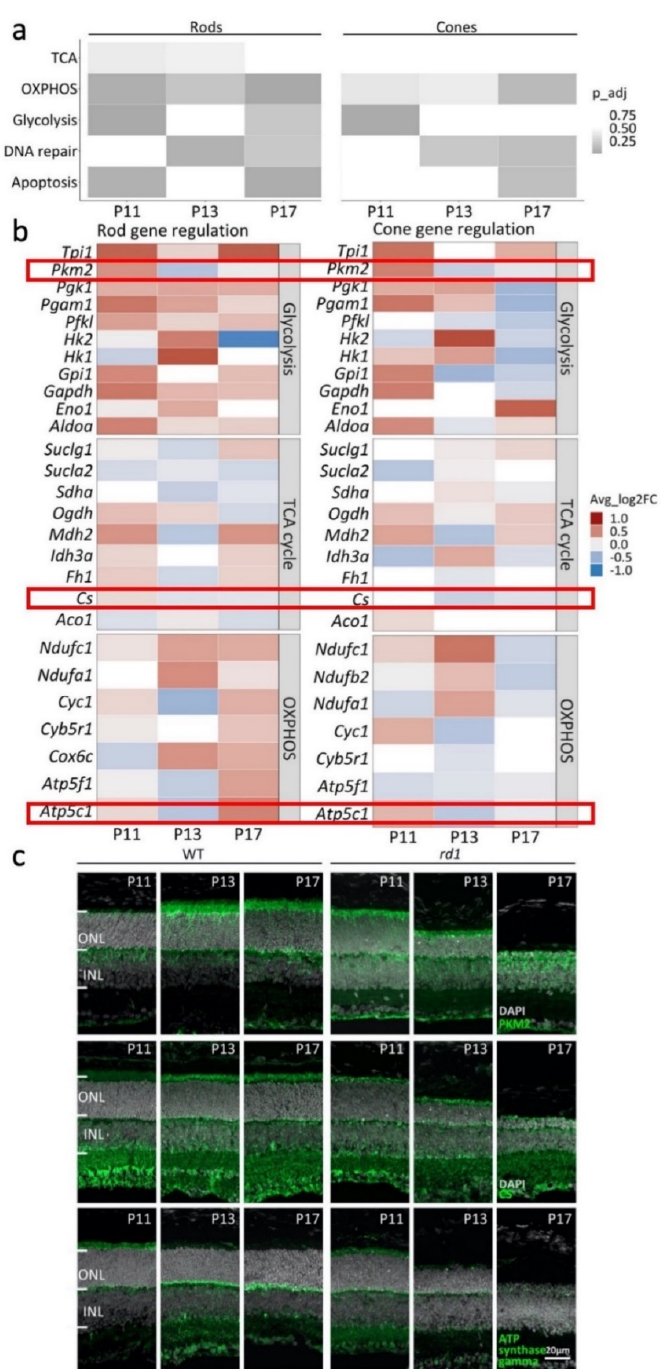
Figure 6. Analysis of genes and enzymes of the TCA cycle, OXPHOS, and glycolysis. ( a ) Gene set enrichment analysis (GSEA) of differentially expressed genes (DEGs) performed on retinal degeneration − 1 ( rd1 ) vs. wild − type (WT) retina. Heatmap showing rod and cone DEGs differentially enriched from postnatal (P) day 11 to P17, in five pathways: tricarboxylic acid (TCA) cycle, oxidative phosphorylation (OXPHOS), glycolysis, DNA repair, and apoptosis. ( b ) Heatmap showing rd1 /wt gene expression changes in individual genes involved in glycolysis, TCA cycle, and OXPHOS. Key enzymes highlighted by red frames. Gene squares filled in white when p -value > 0.5. ( c ) Immunofluorescence (IF) staining for citrate synthase (CS), pyruvate kinase (PKM2), and ATP synthase gamma. DAPI (grey) was employed as nuclear counterstain. ONL, outer nuclear layer; INL, inner nuclear layer.